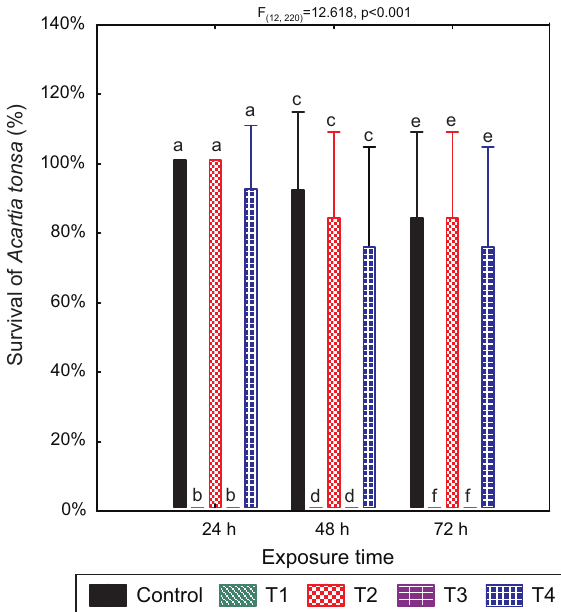
Figure 1 - Two-way ANOVA indicating the survival of Acartia tonsa exposed to different treatments (Control, T1, T2, T3 and T4) after 24, 48 and 72 hours, where control = treatment without antibiotics; T1 = 0.75 g L -1 penicillin G potassium + 0.75 g L -1 streptomycin sulphate; T2 = 0.025 g L -1 penicillin G potassium + 0.08 g L -1 streptomycin sulphate + 0.04 g L -1 neomycin sulphate; T3 = 0.63 g L -1 penicillin G potassium + 0.3 g L -1 streptomycin sulphate + 0.05 g L -1 neomycin sulphate + 0.01 g L -1 chloramphenicol; T4 = 0.02 g L -1 oxytetracycline hydrochloride. Bars represent confidence intervals (95 %) and lowercase letters indicate similarities or statistical differences between treatments for each time evaluated.